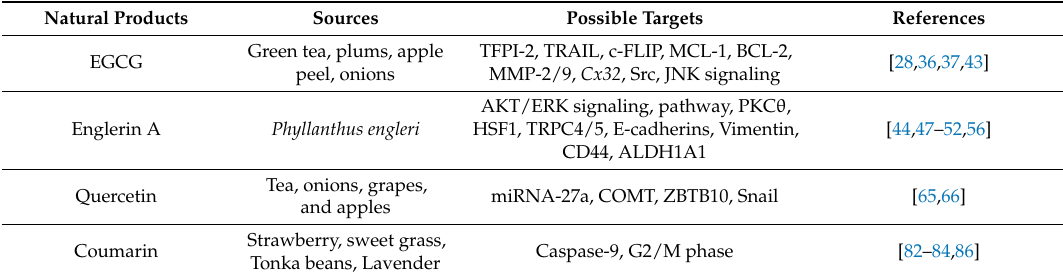
Table 1. Anticancer Indications of Natural Products in Renal Cell